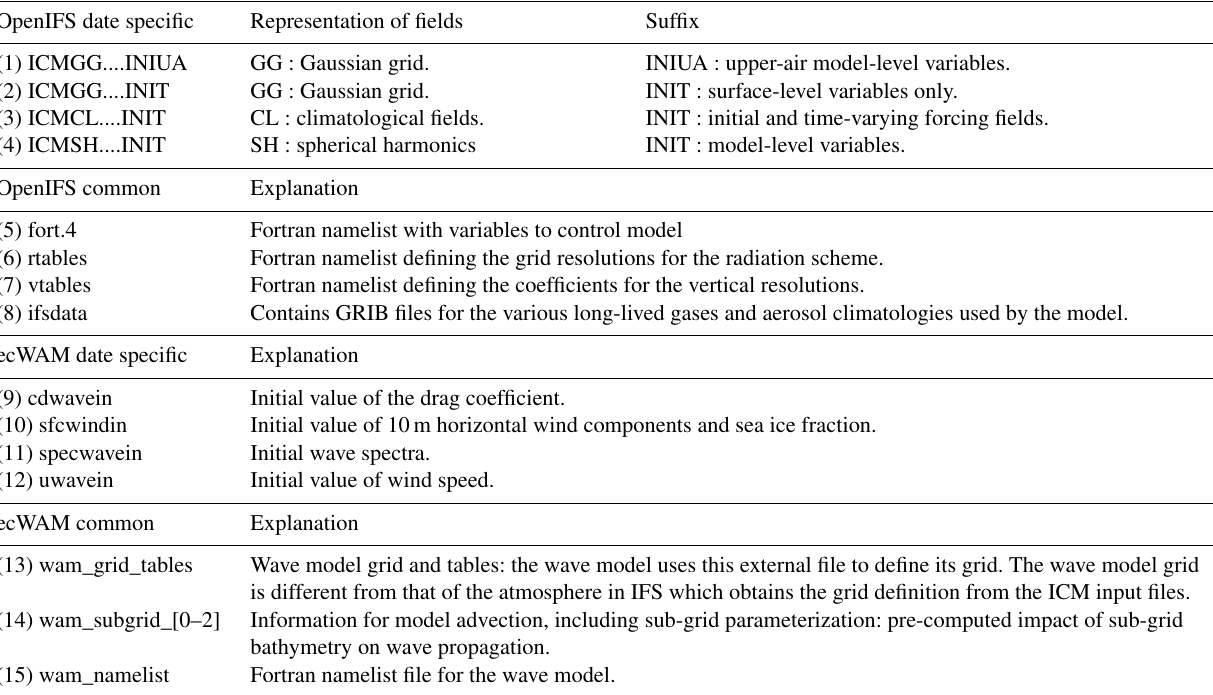
Table 1. Description of the OpenIFS and ecWAM initialization files. OpenIFS date